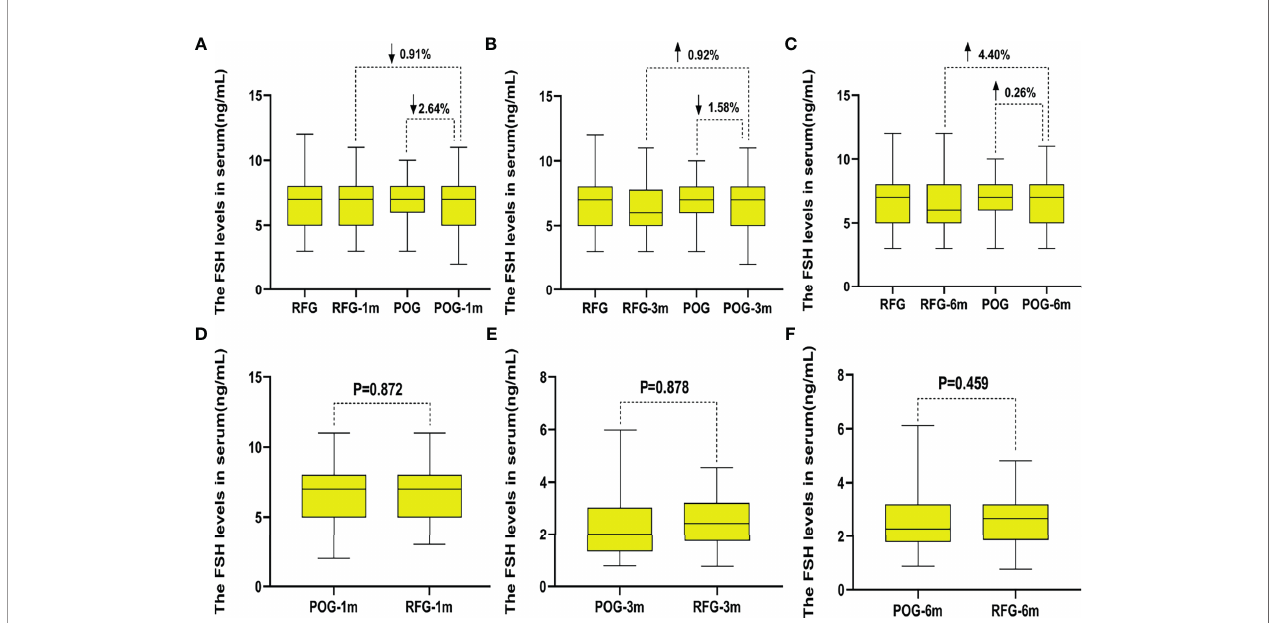
FIGURE 6 | The changes of follicle-stimulating hormone (FSH) levels in the two groups. Compared with preoperative, the increased rate of FSH levels in postoperative observation group (POG) after the fi rst postoperative month was 2.64%. Compared with E2 levels of referent group (RFG), the decline rate of FSH levels in POG after the fi rst postoperative month was 0.91% (A) . Compared with preoperative, the decline rate of FSH levels in POG after third postoperative month was 1.58%. Compared with FSH levels of RFG, the increased rate of FSH levels in POG after the third postoperative month was 0.92% (B) . Compared with preoperative, the increased rate of FSH levels in POG after the sixth postoperative month was 0.26%. Compared with FSH levels of RFG, the increased rate of FSH levels in POG after the sixth postoperative month was 4.40% (C) . The FSH levels showed no signi fi cant difference in POG in the fi rst, third, and sixth month when compared with that in RFG (p = 0.872, p = 0.878, p = 0.459, respectively) (D – F)